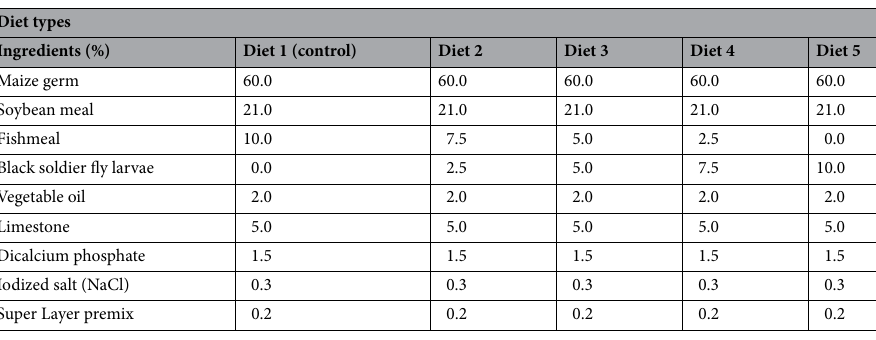
Table 1. Feed composition of the formulated diets fed to chicks for a period of eight (8) weeks 26 . Super